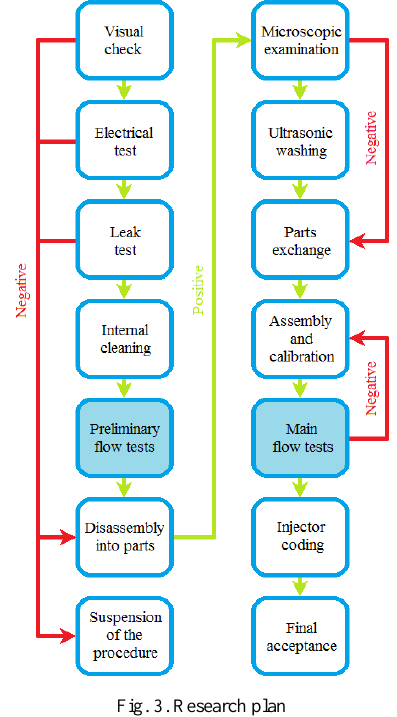
Fig. 3. Research plan